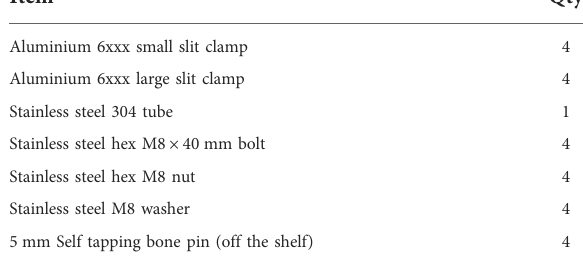
TABLE 1 Imperial external fi xator single clamp unit